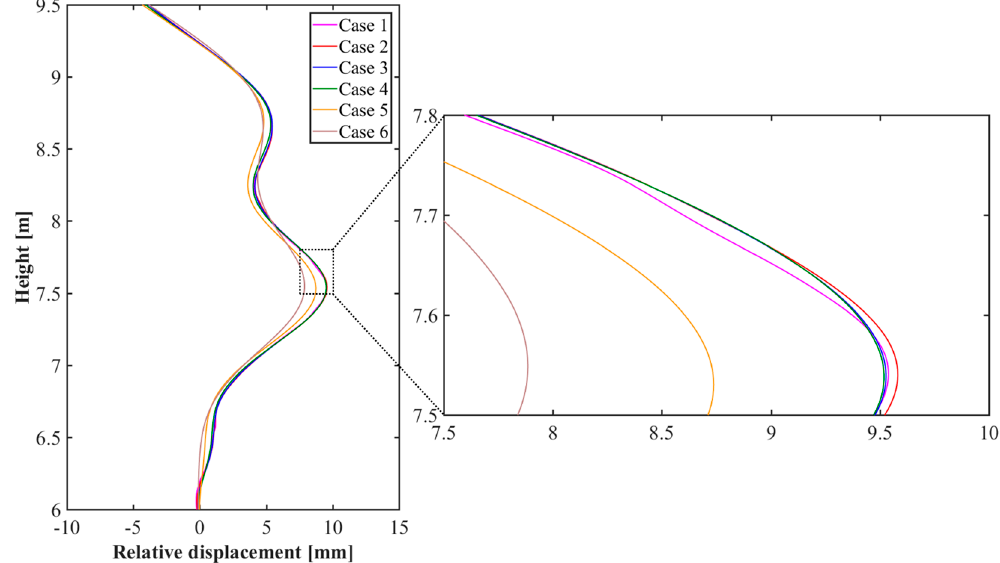
Figure 13. Comparison of the relative displacements for cases 1–6.